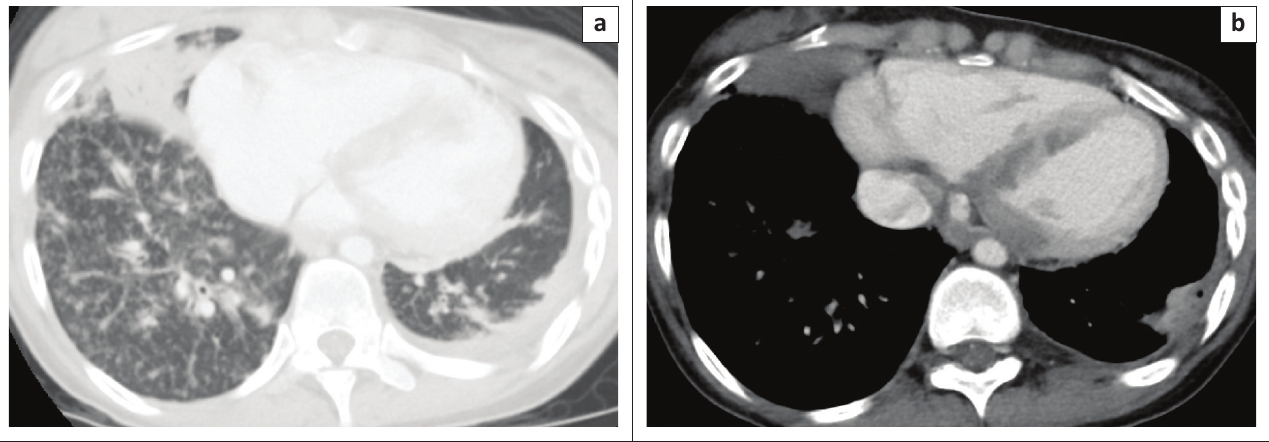
FIGURE 4: Axial CT images of the lower lung fields (a) and at the level of the left ventricle